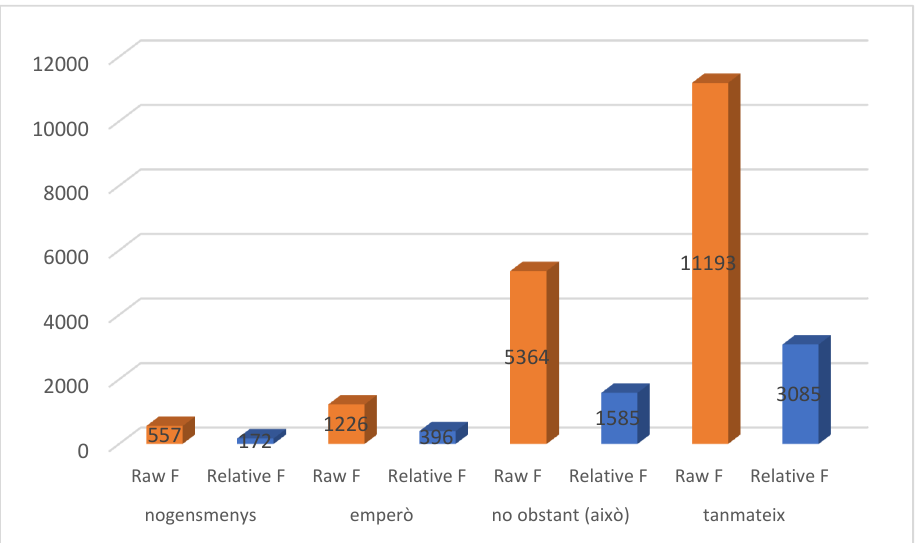
Figure 1. Raw and relative frequency (normalized per 1 million words) of the connectives analyzed.